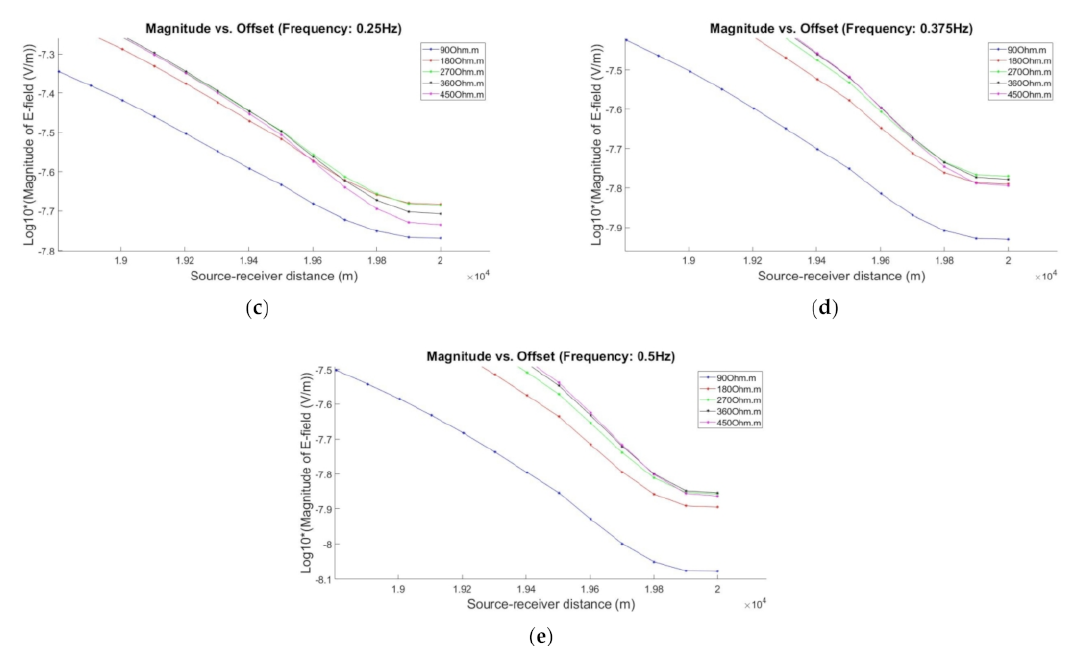
Figure 4. The zoom-in scaled of magnitude of electric field (E-field) versus offset at far source-receiver separation distances for five different transmission frequencies: ( a ) 0.0625 Hz, ( b ) 0.125 Hz, ( c ) 0.25 Hz, ( d ) 0.375 Hz, and ( e ) 0.5